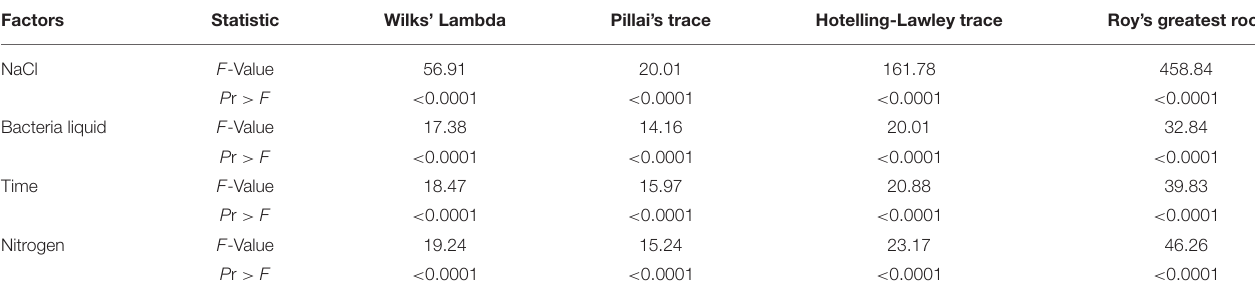
TABLE 6 | Multivariate analysis of variance (MANOVA) test criteria and F approximations for the hypothesis of no overall effects of the factors. Factors Statistic Wilks’ Lambda